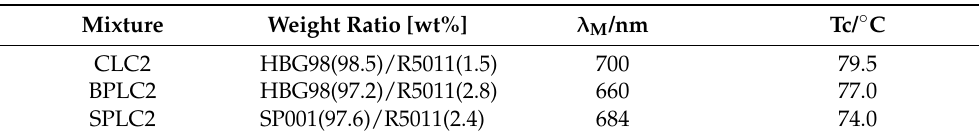
Figure 10. The reflection spectra of CLC1, BPLC1, and SPLC1. Table 3. Compositions, reflection central wavelengths, and clearing points of CLC2, BPLC2, and SPLC2.